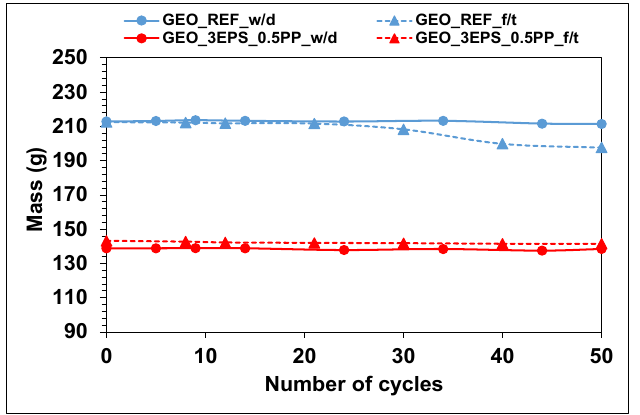
Figure 13. Mass of the examined specimens exposed to wet–dry and freeze–thaw cycles.